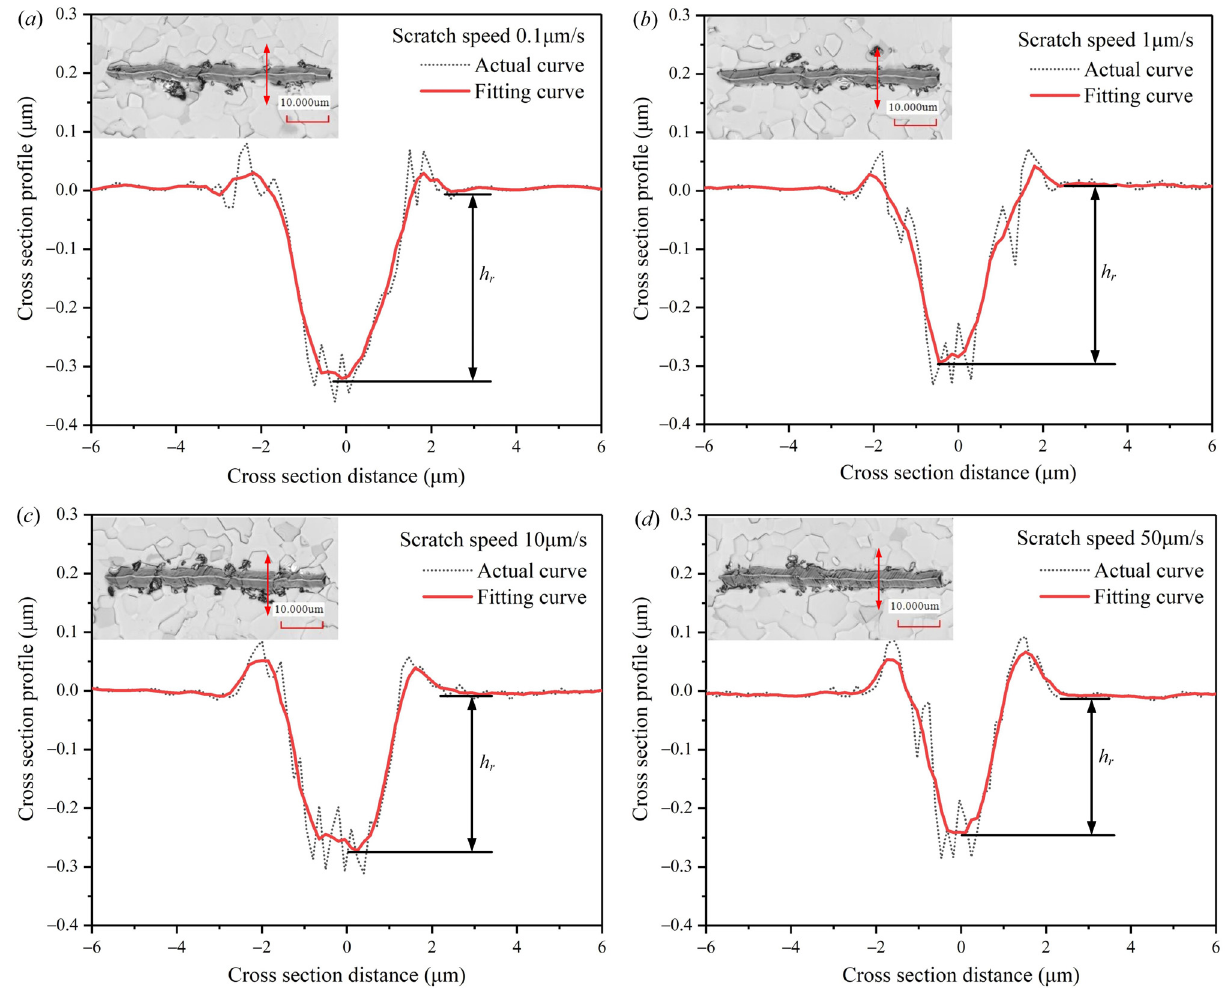
Figure 10. Cross-section profiles and residual depths of the scratches at different scratch speeds. ( a ) is the scratch speed at 0.1 μ m/s. ( b ) is the scratch speed at 1 μ m/s. ( c ) is the scratch speed at 10 μ m/s. ( d ) is the scratch speed at 50 μ m/s.